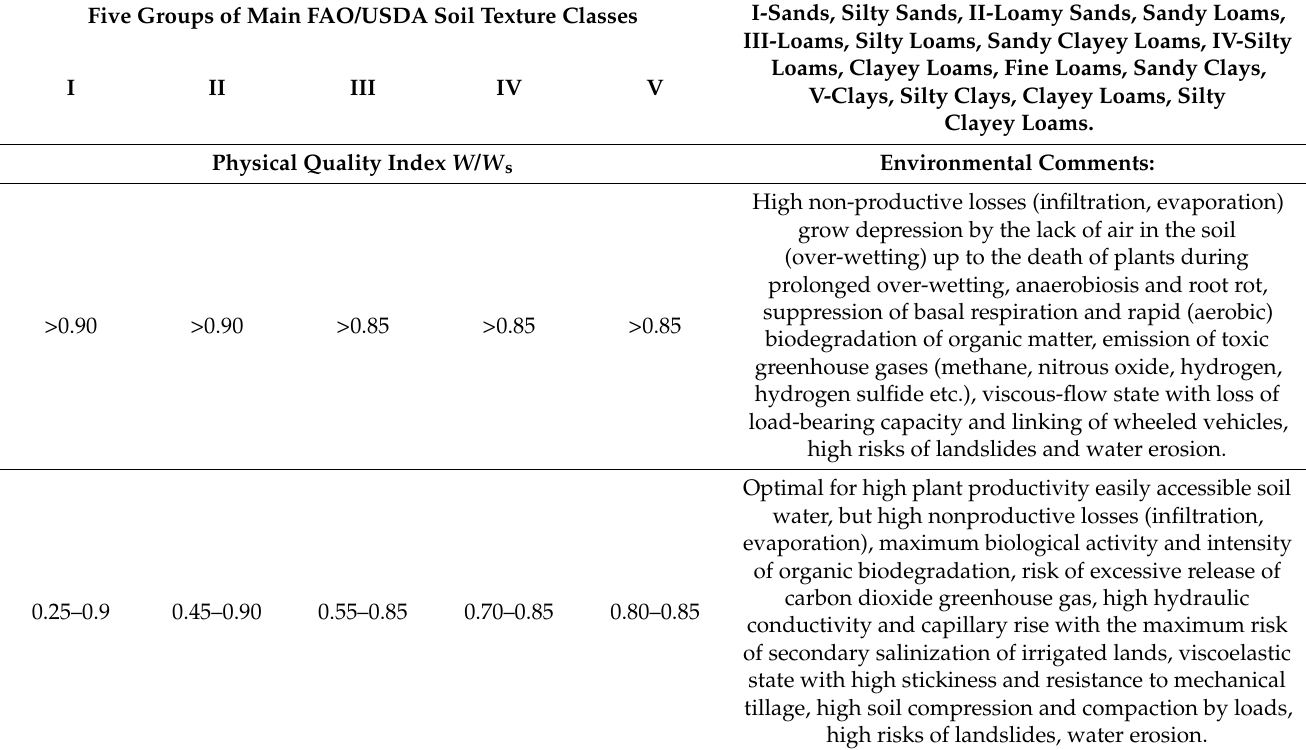
Table 3. Soil physical quality standards using W/W s